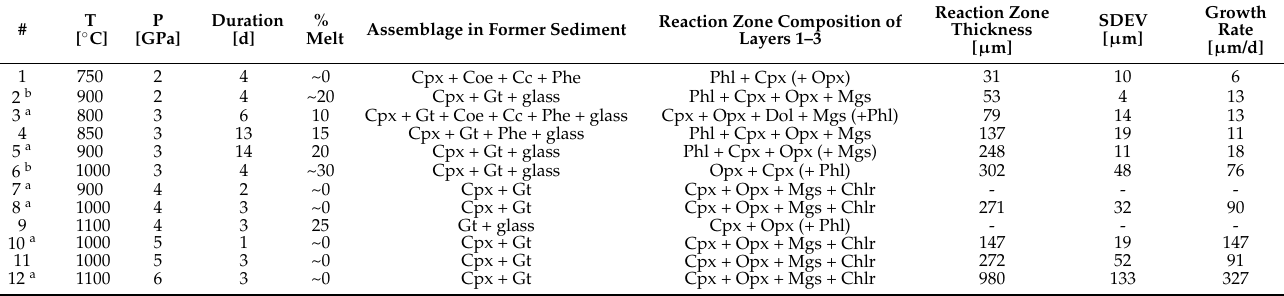
Table 1. Experimental conditions and run products of the reaction of sediment + H 2 O + CO 2 with dunite.